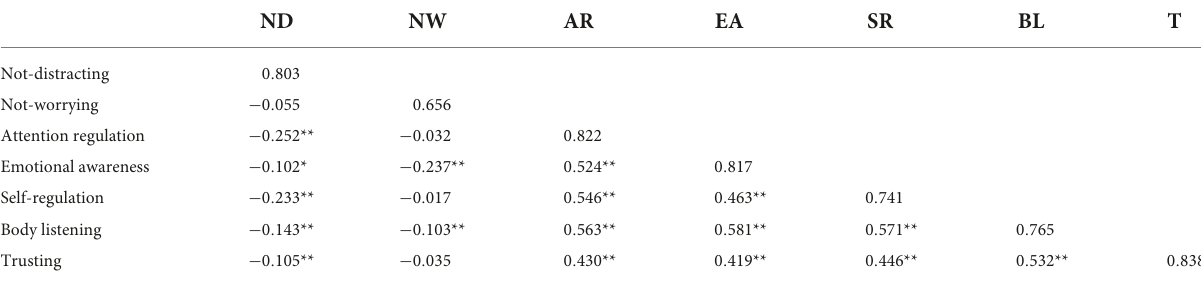
TABLE 1 Pearson product-moment correlations among the seven multidimensional assessment of interoceptive awareness (MAIA) scales and Cronbach’s alpha. ND NW AR EA SR BL T